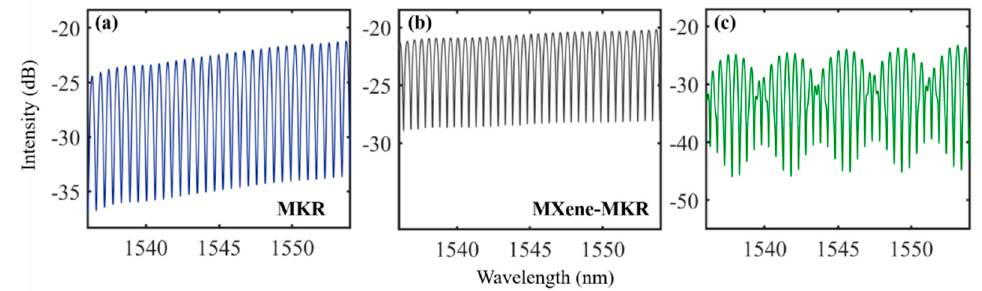
Figure 5. Transmission spectra of the ( a ) MKR; ( b ) MXene-MKR; ( c ) cascade system.